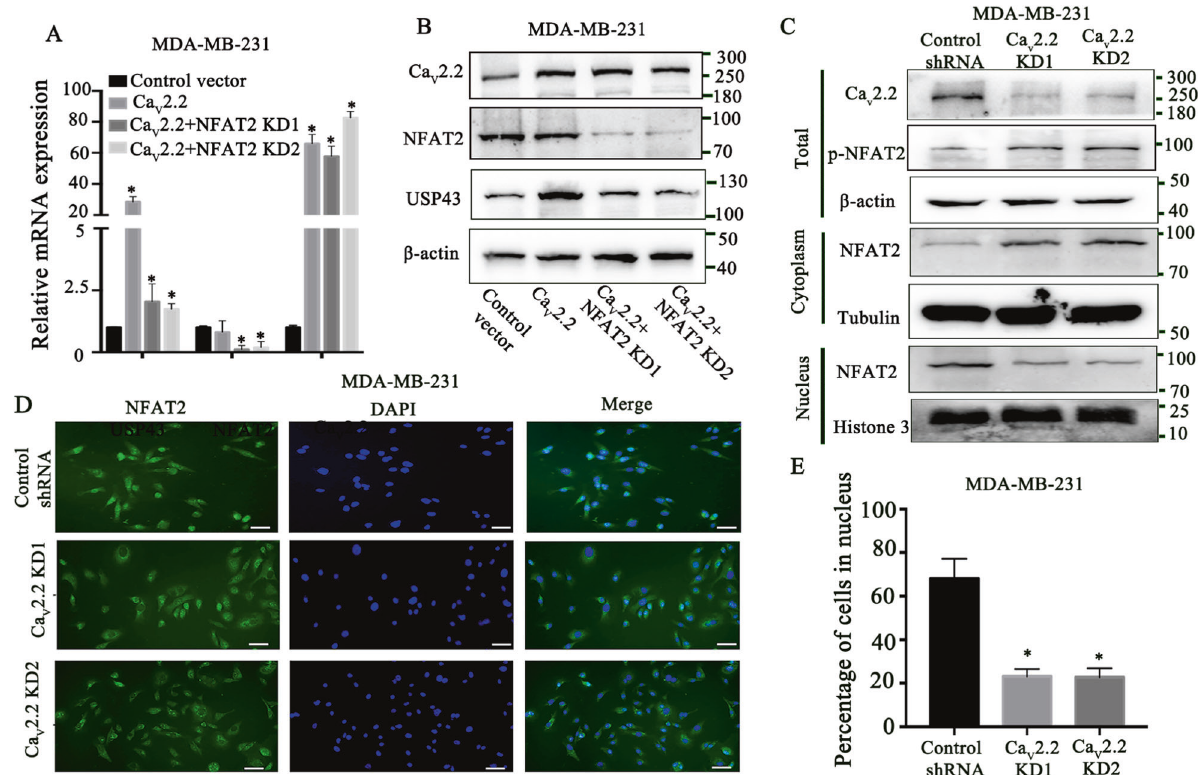
Fig. 8 Cav2.2 regulates USP43 expression through NFAT2 dephosphorylation. A USP43, NFAT2, and Ca v 2.2 expression were determined by qRT-PCR in MDA-MB-231 cells expressing Ca v 2.2 cDNA and NFAT2 shRNA or a control shRNA. P value was determined using Student ’ s t-test (* p < 0.001). Error bars represent mean ± s.d. B Ca v 2.2, NFAT2, and USP43 expression were determined by immunoblotting in MDA-MB-231 cells expressing Ca v 2.2 cDNA and NFAT2 shRNA or a control shRNA. C Ca v 2.2 and phosphorylated NFAT2 expression were determined by immunoblotting in MDA-MB-231 cells expressing Ca v 2.2 shRNA or a control shRNA. NFAT2 expression in cyltoplasm and nucleus were determined by immunoblotting in MDA-MB-231 cells expressing Ca v 2.2 shRNA or a control shRNA. D The subcellular localization of NFAT2 was determined by immuno fl uorescence in MDA-MB-231 cells expressing Ca v 2.2 shRNA or a control shRNA. Representative images were shown.